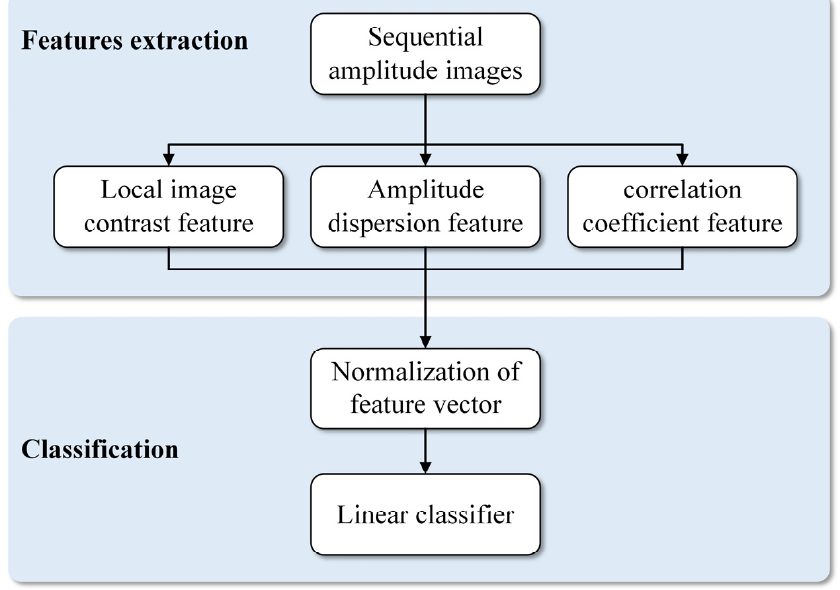
Figure 5. Screening process flow of the SPCP.